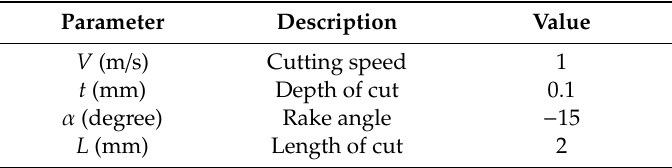
Figure 6. Synthetic workpieces with seed cracks of di ff erent angles: ( a ) 0 ◦ , ( b ) 45 ◦ , ( c ) 90 ◦ , and ( d ) 135 ◦ . Table 5. Cutting conditions for the simulation.